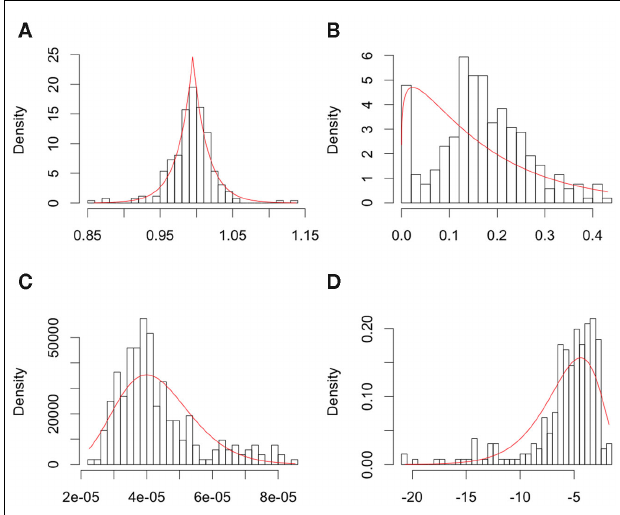
FIGURE 2 | Plots of individual hill slope parameters for Gemcitabine. Histograms represent parameters estimated from observed real data, while red lines represent the distribution for parameters used in simulation. (A–D) represent the distributions for the Max, Min, IC50, and slope parameters,